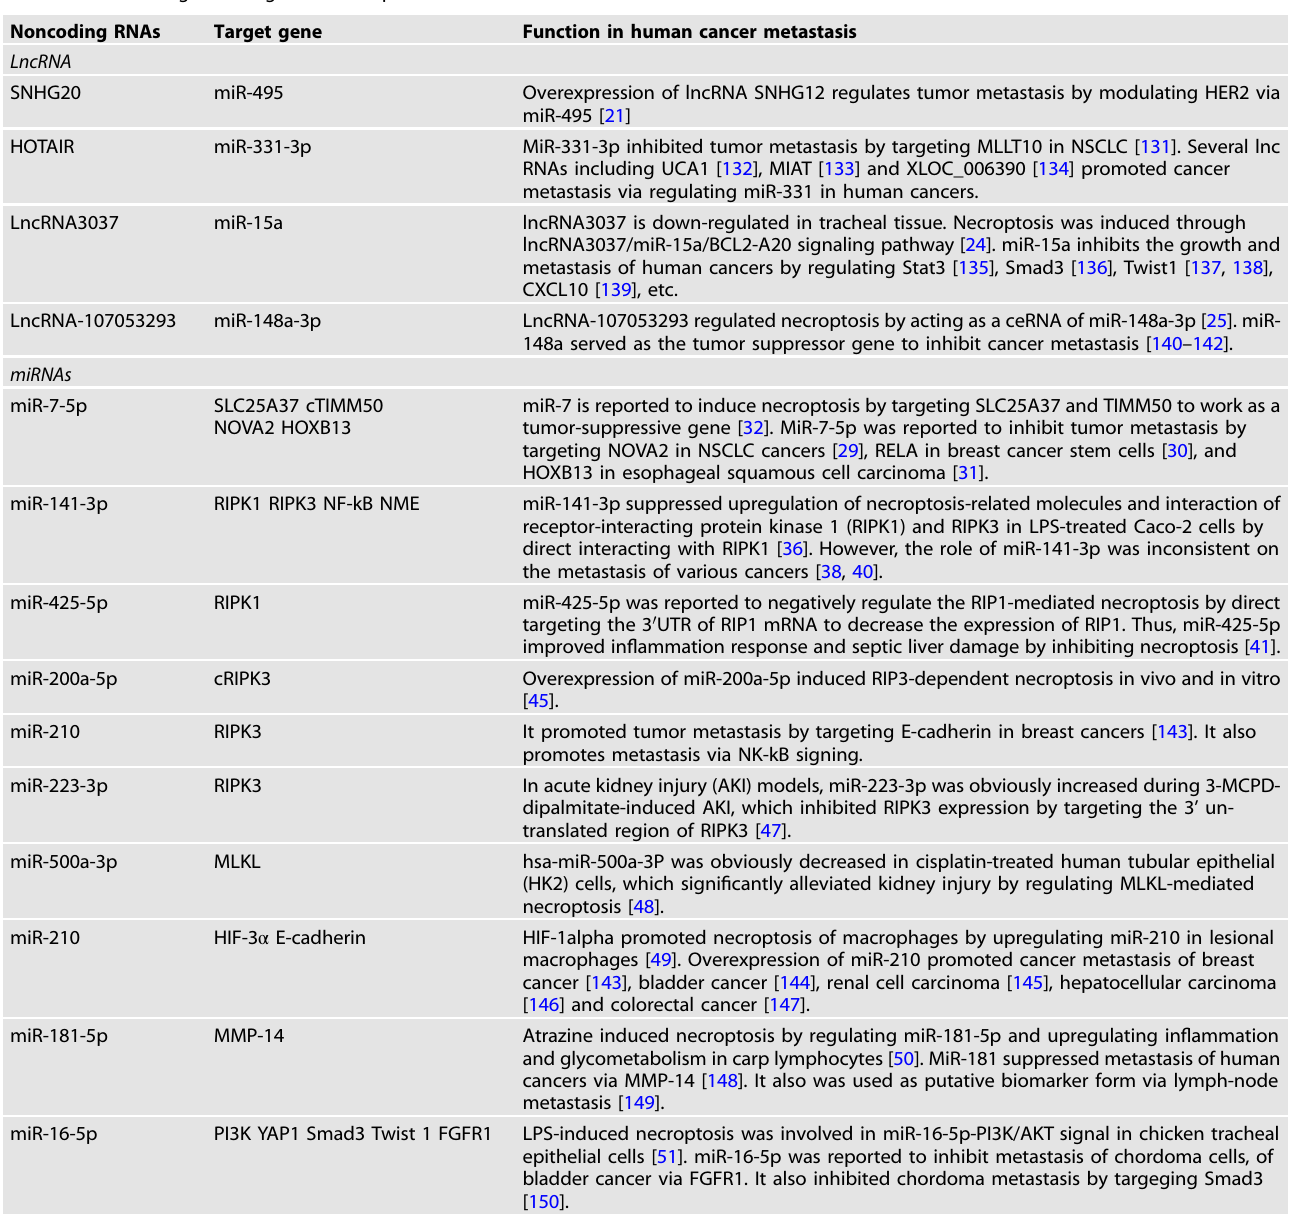
Table 1. Noncoding RNAs regulates necroptosis in cancer